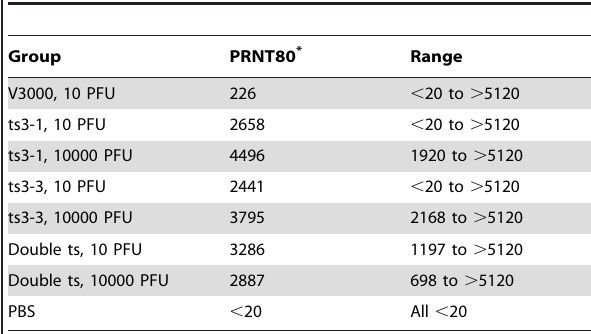
Table 2. Serum neutralizing titers of groups inoculated with VEEV ts mutants.